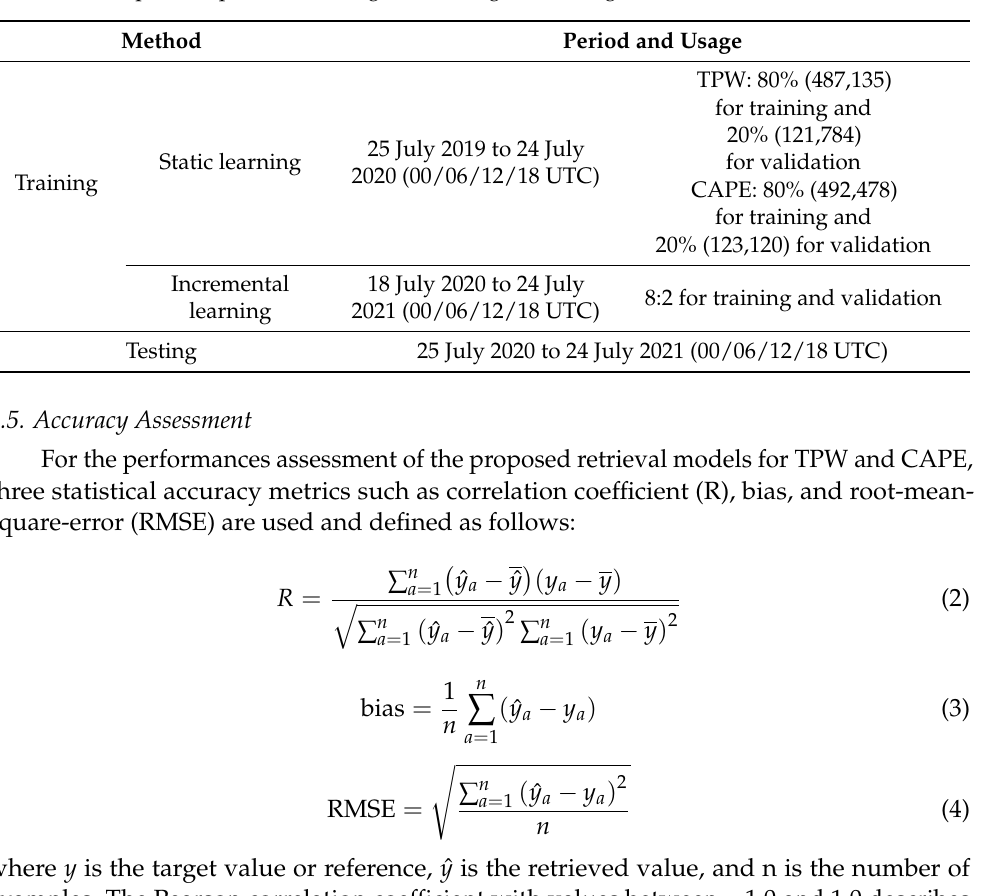
Table 3. Description of period and usage of training and testing